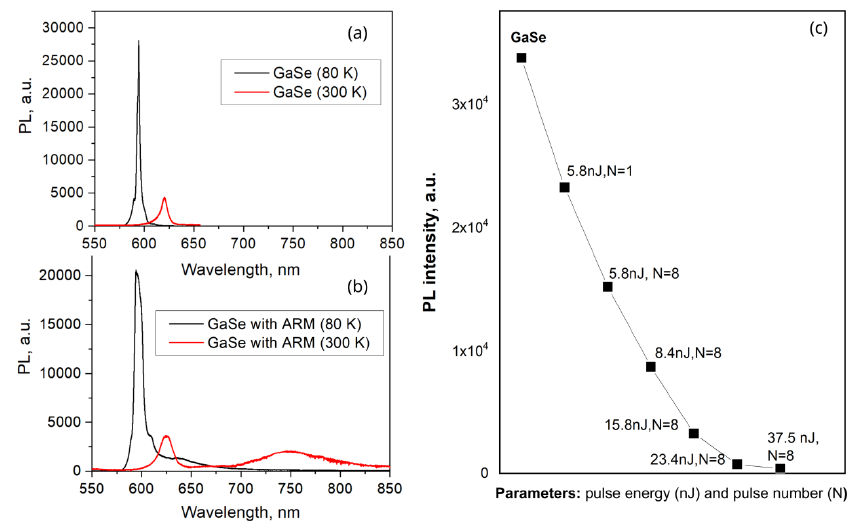
Figure 12. PL spectra for GaSe ( a ) and GaSe with an ARM ( b ) measured at 300 K (red line) and 80 K (black line) at 532 nm excitation. ( c ) The dependence of the intensity of the main PL line (at T = 80 K) on the parameters of laser pulses (energy per pulse and the number of pulses for the creation of one crater in an ARM at GaSe).